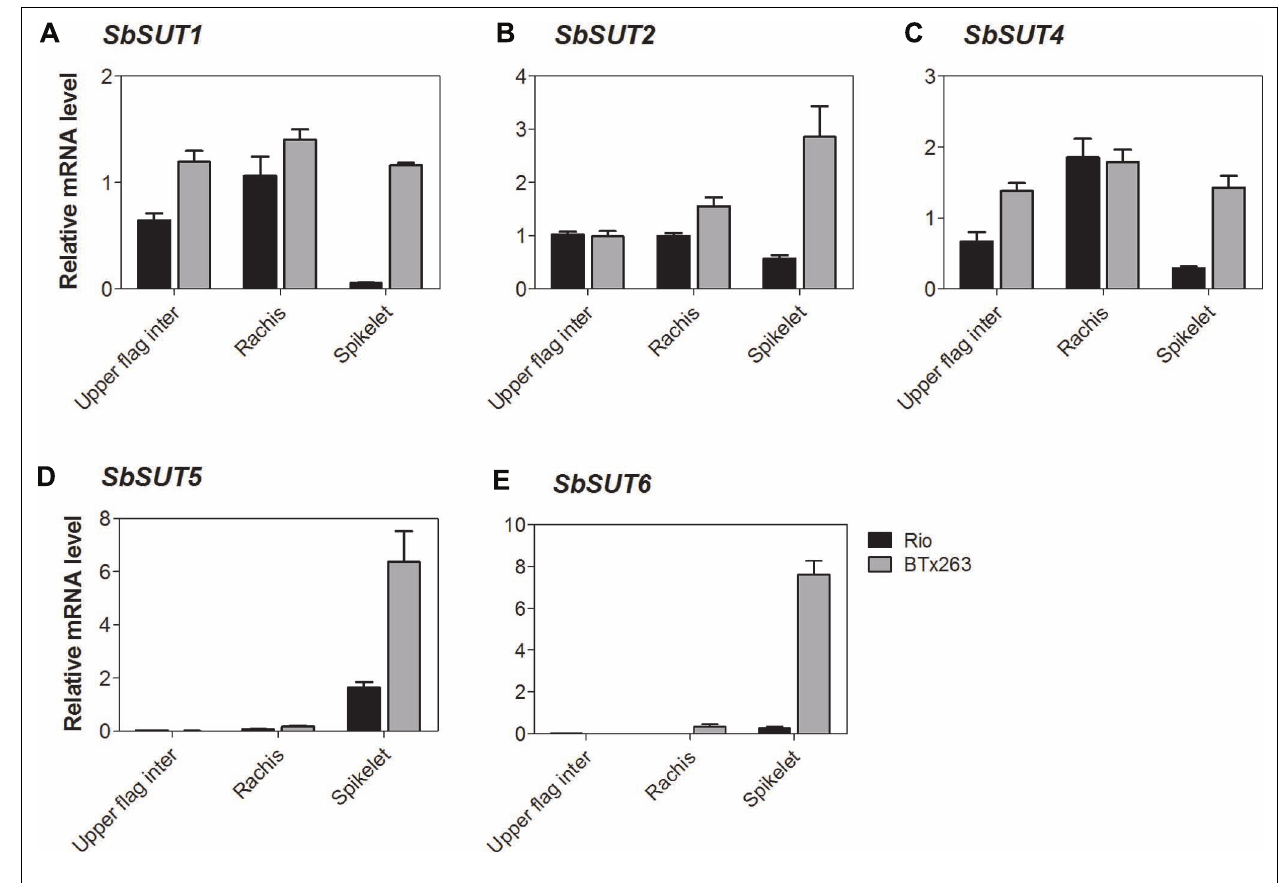
FIGURE 7 | Sorghum SUT transcript levels at anthesis in the upper portion of the flag internode and within the inflorescence. Relative expression at anthesis of the Sorghum SUTs (A) SbSUT1 ; (B) SbSUT2 ; (C) SbSUT4 ; (D) SbSUT5 ; (E) SbSUT6 . Levels of SUT expression were